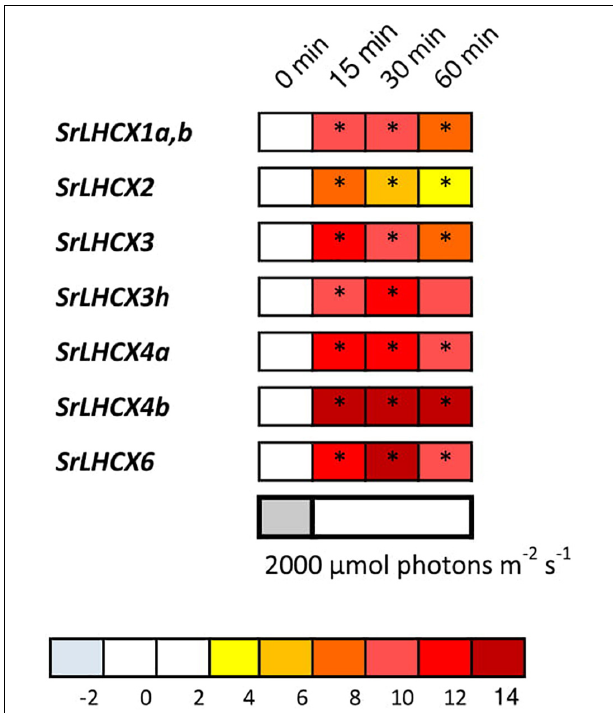
FIGURE 3 | LHCX transcription levels during exposure to high light (2,000 µ mol photons m − 2 s − 1 ). Expression ratios are log 2 transformed and indicated by the color chart. Values are averages of three independent biological replicates and relative to the respective initial values (LL). Significant changes at p < 0.05 (Pairwise Fixed Reallocation Randomization Test performed by REST2006) are indicated with an asterisk.